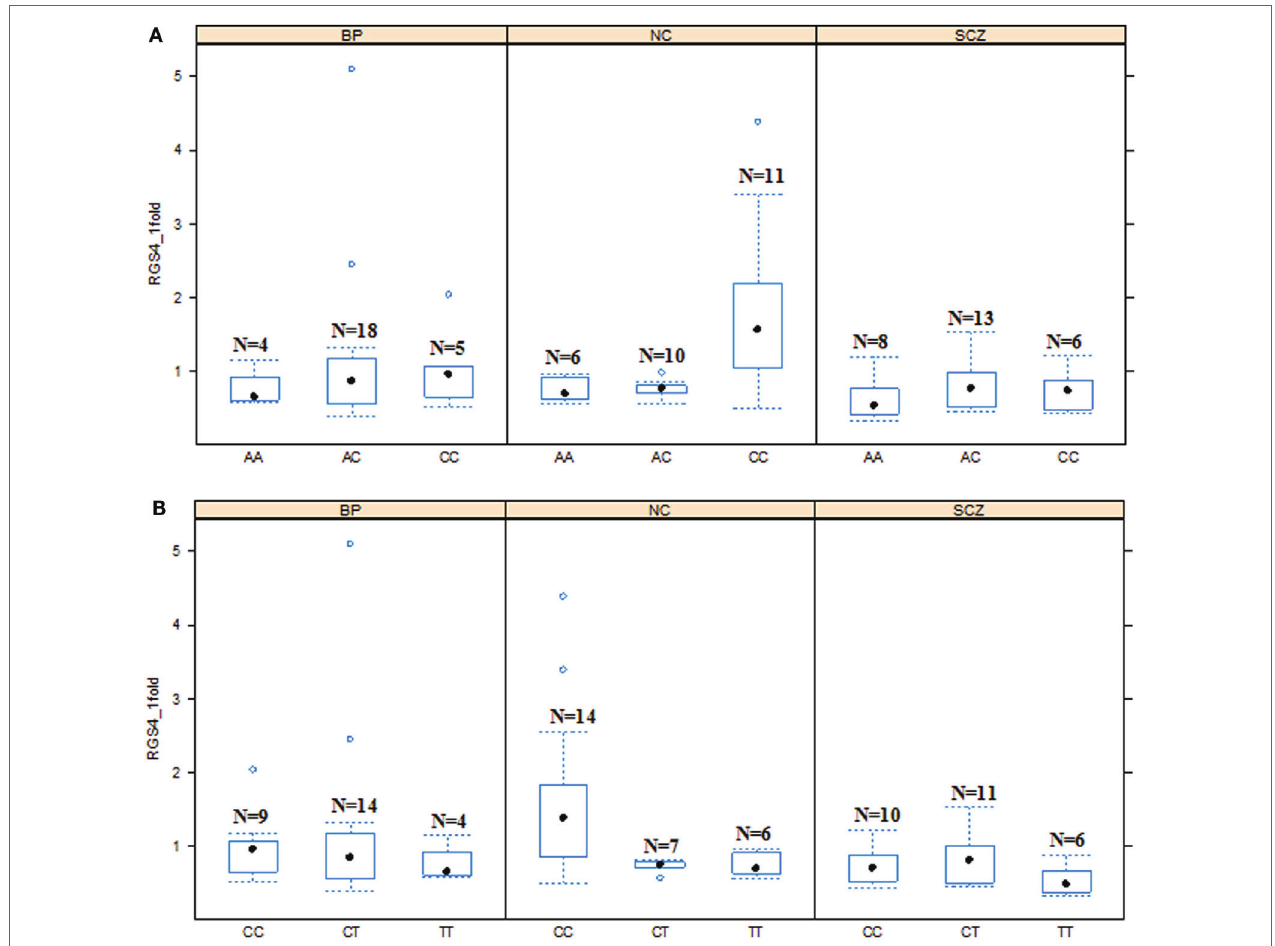
FigUre 5 | effects of snP4 and snP7 genotypes on RGS4-1 mrna expression among the groups . (a) . In the schizophrenia (SCZ) group, the subjects with genotype CC of SNP4 tended to have lower mRNA expression level of RGS4-1 than the subjects with the same genotype CC of SNP4 in NC ( p = 0.0984) (B) . The mRNA of RGS4-1 in SCZ patients with genotype CC of SNP7 was lower than those of the individuals with the same genotype CC in NC ( p =